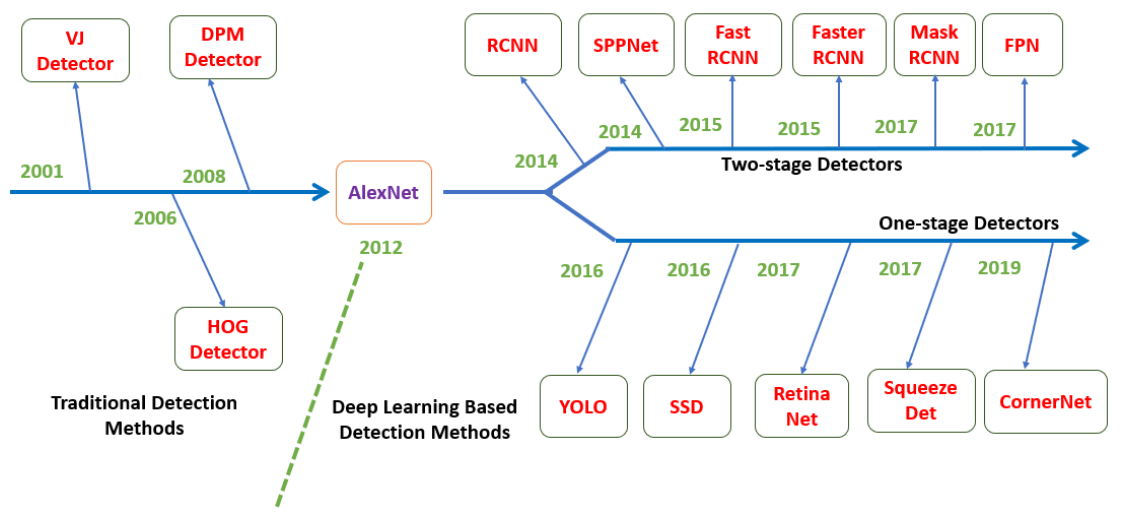
Figure 1. Milestones of object detection. In 2012 the major turning point was the use of DCNN implemented for image classification by Krizhevsky et al. [1], VJ Det. [11,12], HOG Det. [13], DPM [14–16], RCNN [17], etc. (source: